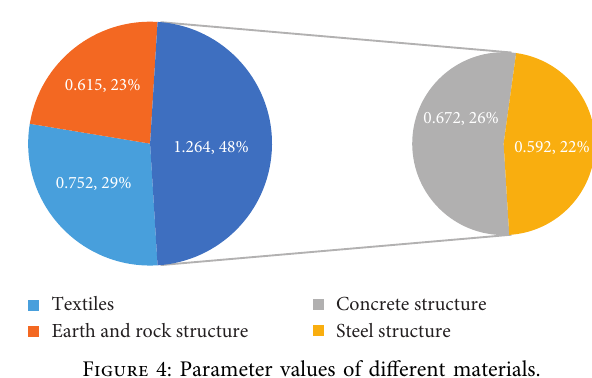
Figure 4: Parameter values of different materials.